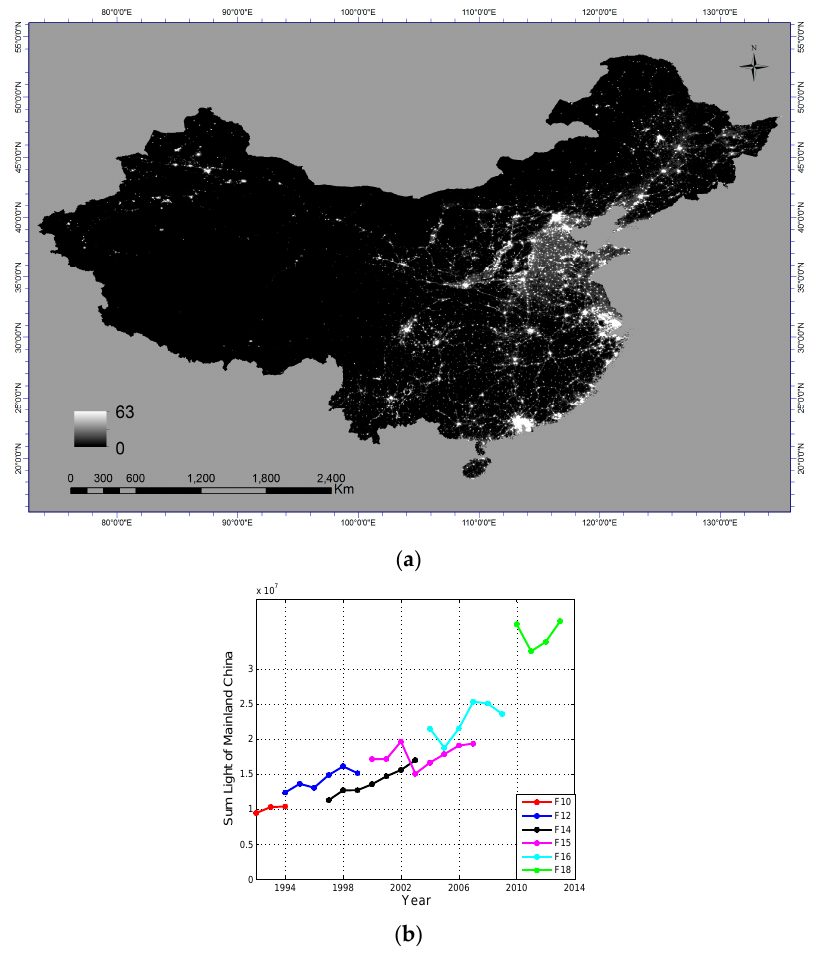
Figure 1. Study area and its DN values: ( a ) NTL data of Mainland China in 2002 by DMSP/OLS; ( b ) summation of DN values over years for different satellites before inter-calibration.